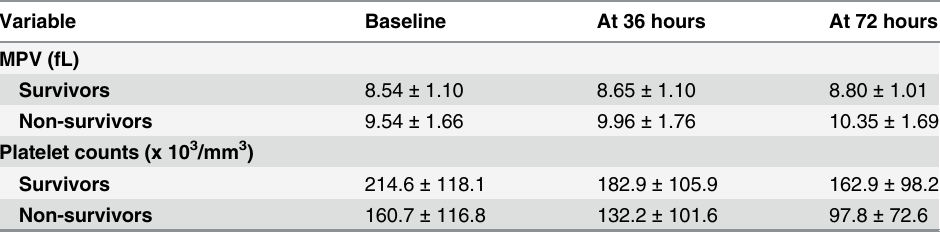
Table 2. Trends in the platelet indices during the fi rst 72